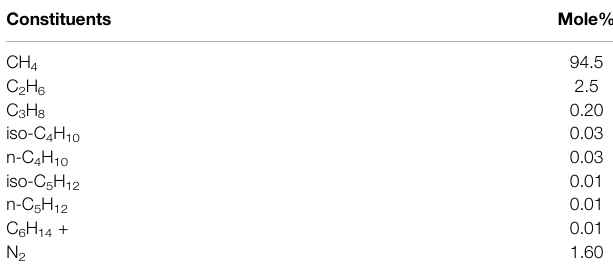
TABLE1| Constitutionsofnaturalgas(ThimmandSullivan,2004;Getzingeretal., 2015; Ullah et al., 2018).